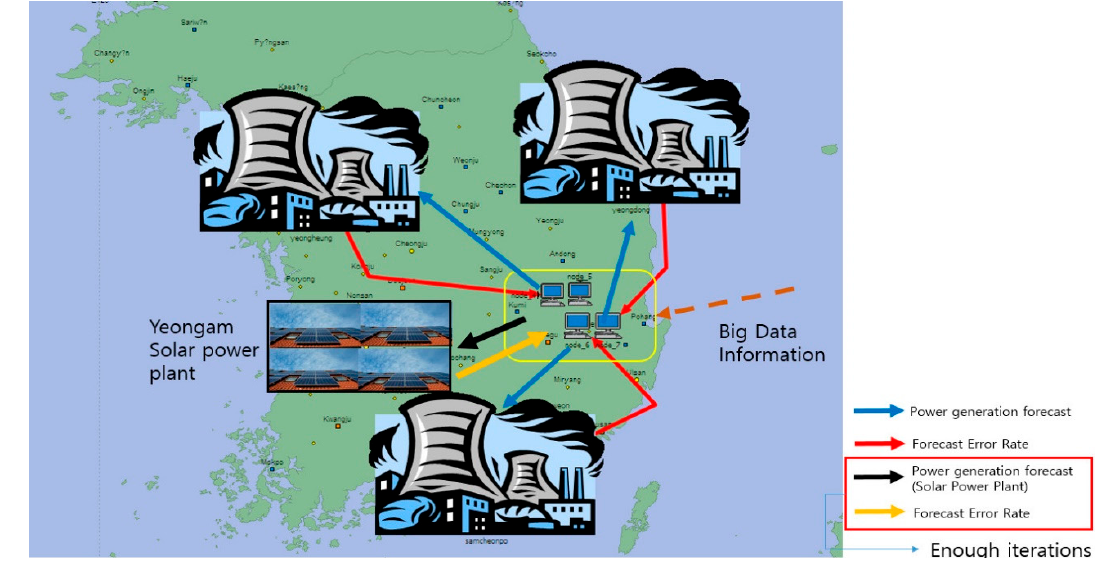
Figure 29. Development of efficient power generation mechanism using information obtained by processing big data collected using web crawling functional system diagram.